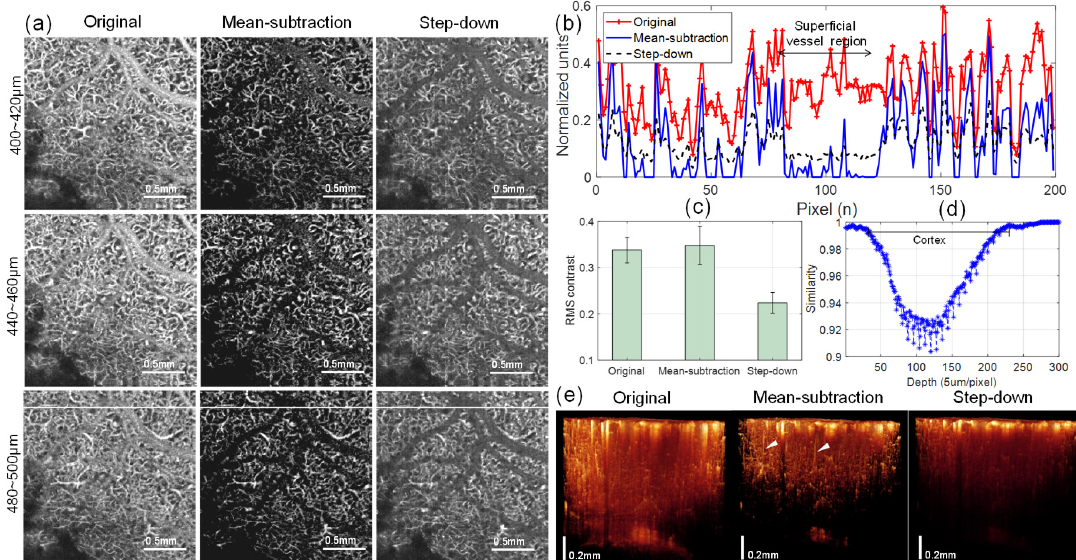
Figure 5. ( a ) Comparison of original and de-shadowed en face OCTA images (OCT angiograms) at different depth ranges of the mouse cortex using the proposed mean-subtraction method and the step-down method: (top) 400–420 µ m, (middle) 440–460 µ m, and (bottom) 480–500 µ m below the cortical surface. For all de-shadowed images processed with the mean-subtraction method (second column in ( a )), the contrast in vascularized regions is improved and the projections of overlying vessels are removed, as observed from the intensity profiles ( b ) taken along horizontal lines (white) on the angiograms at the bottom panel of ( a ). ( c ) Comparison of root-mean-square (RMS) contrasts calculated from 200 horizontal intensity profiles taken at each angiogram (440–460 µ m) of ( a ). ( d ) A graph of similarity between angiograms as the cortical depth increases. Lower similarity values indicate less correlation between inner angiograms, representing the structural heterogeneity of capillary vessel networks. ( e ) 3-D reconstructions of the volumetric OCT angiograms before (left) and after de-shadowing using the mean-subtraction (middle) and step-down methods (right). The penetrating vessels (arrow heads) in the cortex are only noticeable in the image processed with mean